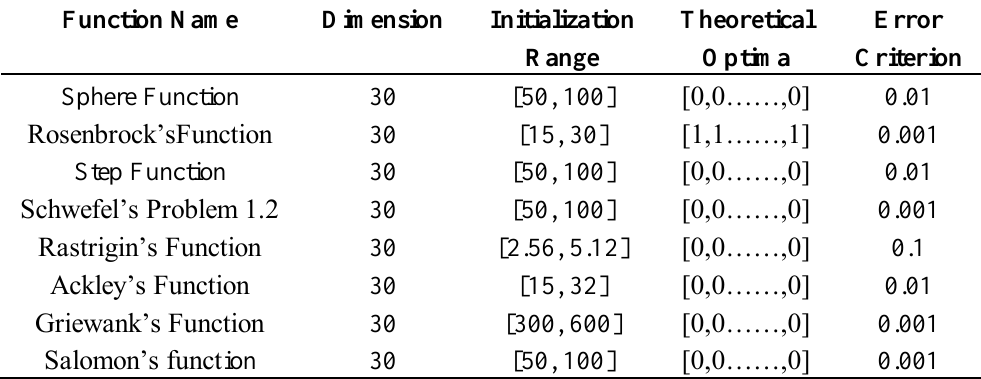
Table 4. Parametric range of benchmark functions.